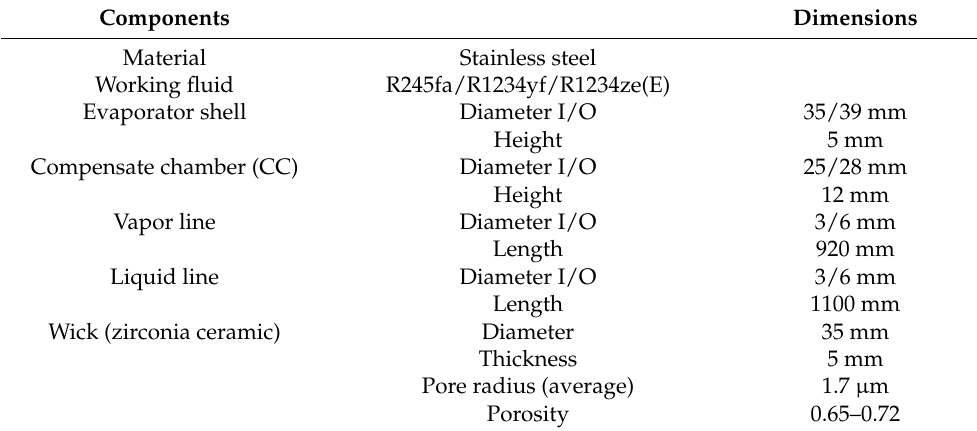
Table 1. The main parameters of the experimental LHP. Components